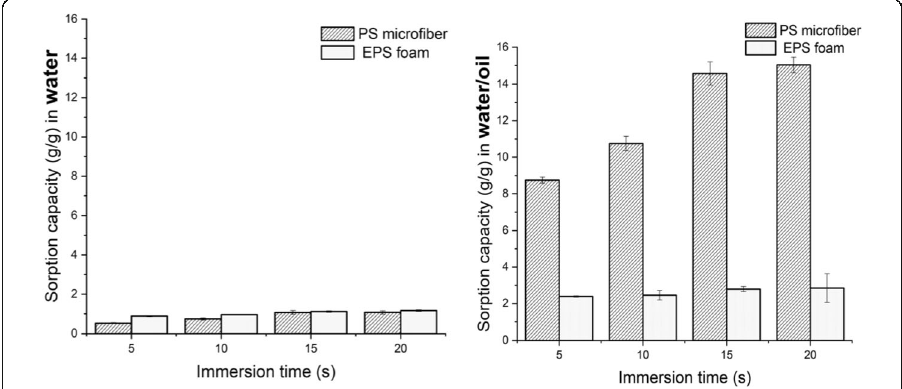
Fig. 8 Bar graph of the sorption capacity of PS microfiber and untreated EPS foam in a water and b water/oil